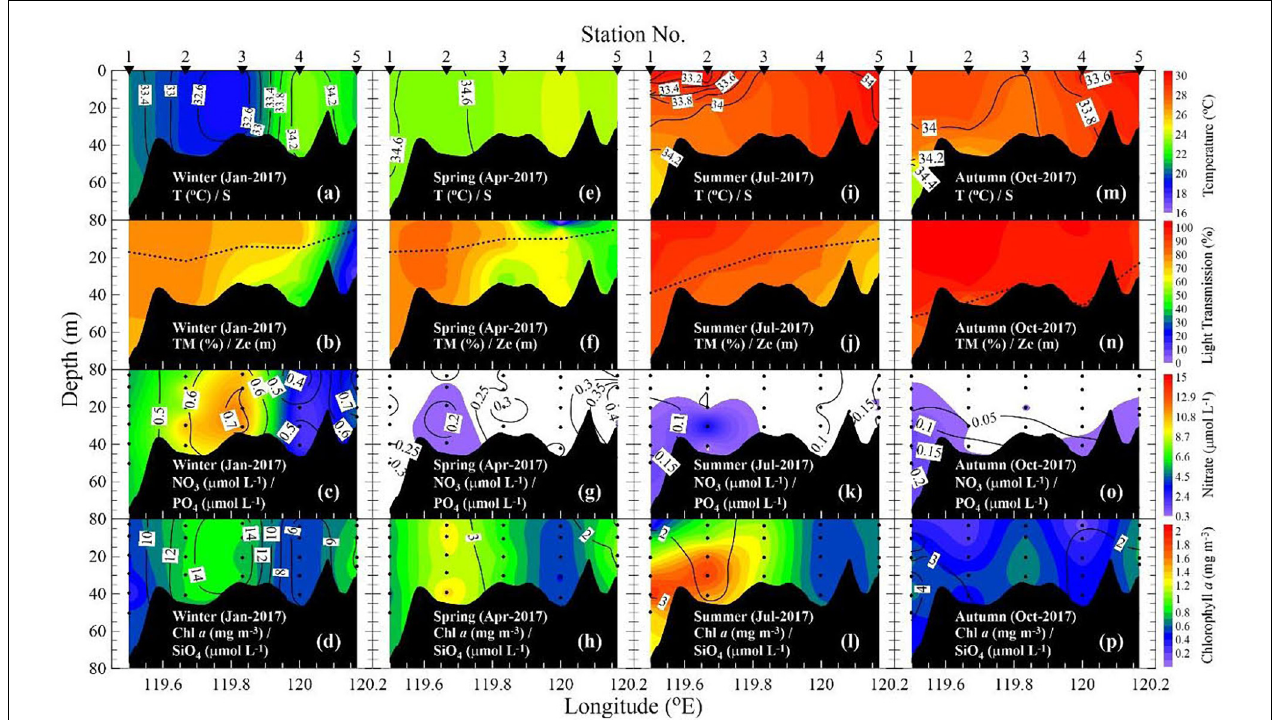
FIGURE 5 | Cross-section of temperature (T)/salinity (S), light transmission (TM)/the dotted line represents the euphotic zone depth (Ze), NO 3 − /PO 43 − and Chl a/ SiO 44 − (a–d) in winter, (e–h) in spring, (i–l) in summer, and (m–p) in autumn.